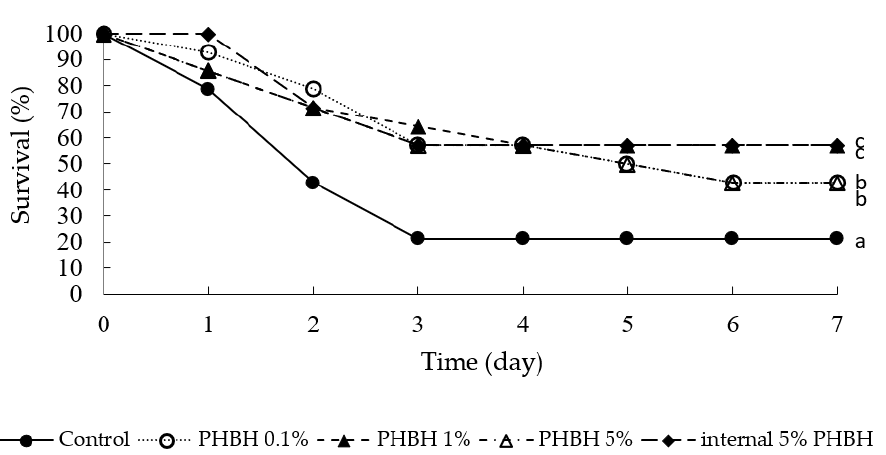
Figure 4. Survival rates of Marsupenaeus japonicus after infection with the shrimp-pathogenic bacterium Vibrio penaeicida . Nine weeks prior to bacterial infection and 1 week after infection, the shrimp were fed the feed containing different amounts of poly-hydroxybutyrate-co-hydroxyhexanoate (PHBH). Different superscript letters show significant differences ( p < 0.05).